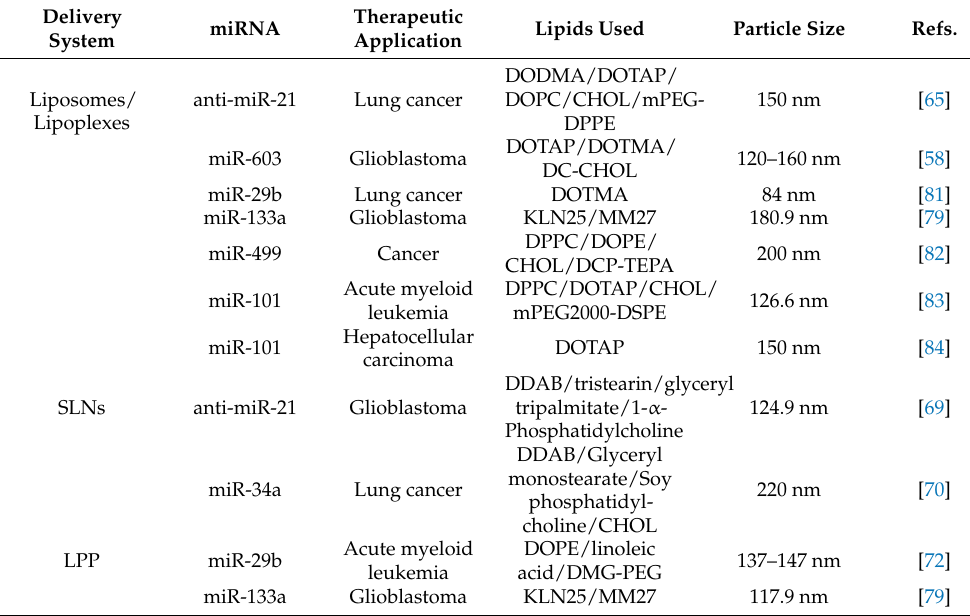
Table 2. Lipid-based miRNA delivery